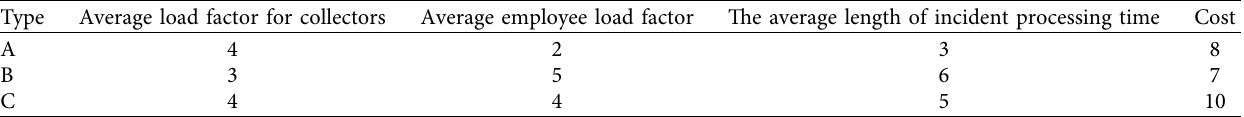
Table 1: Summary of the 3